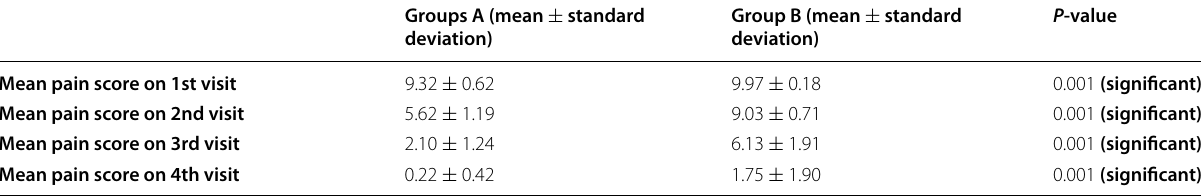
Table 2 Comparison between mean pain scores for both groups on each individual visit